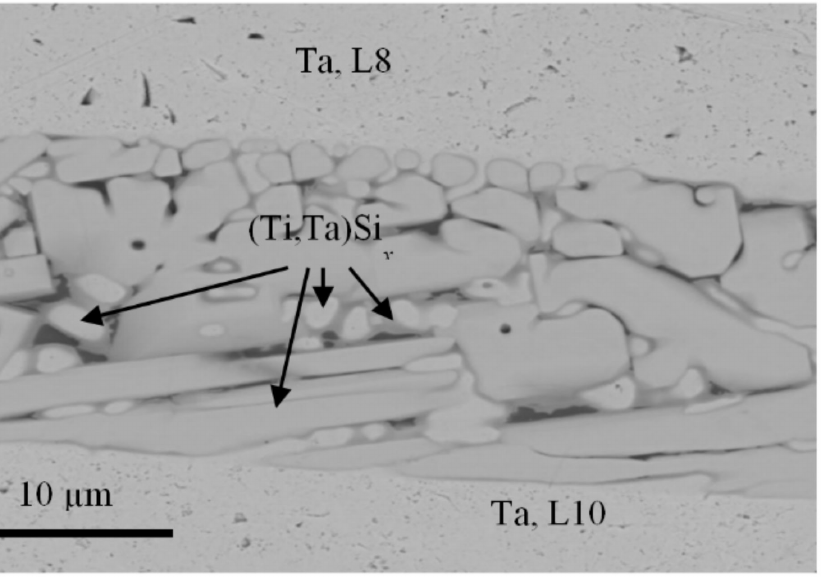
Figure 15. Microstructure of (Ti,Ta)Si x joint formed between Ta layers L8 and L10 (cross section of burned Set 3